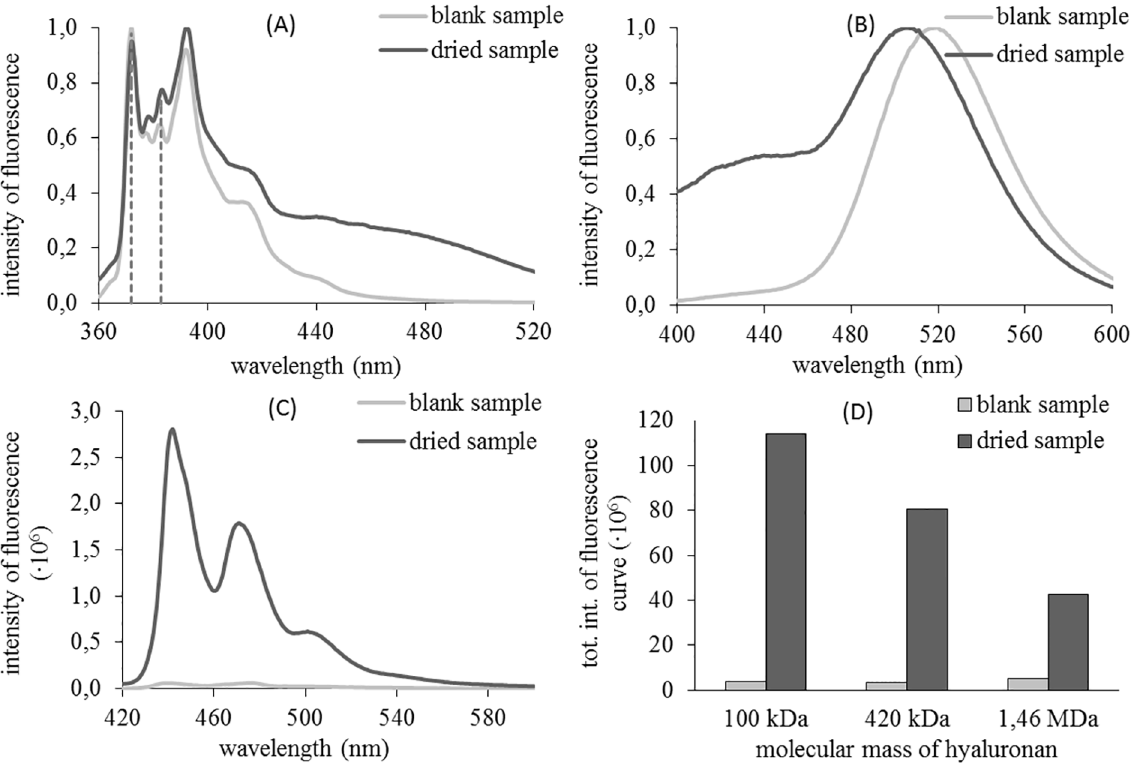
Fig 3. (A) Normalizedemissionspectra of blank and dried sampleswith pyreneand HyA 106 kDa, (B) Normalized emissionspectra of blank and dried samples with prodanand HyA 106 kDa, (C) Emission spectra of blank and dried sampleswith perylene and HyA 106 kDa, (D) The decreasing trend of the total integral of fluorescence intensity for dried samples with an increasingmolecularmass of hyaluronan and peryleneas the fluorescence